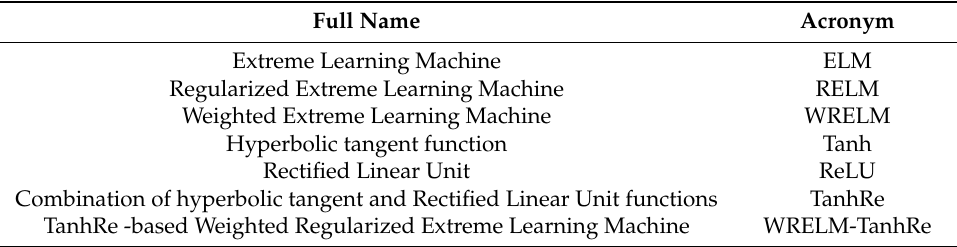
Table 2. Full names and acronyms of the frequently used new terms in Section